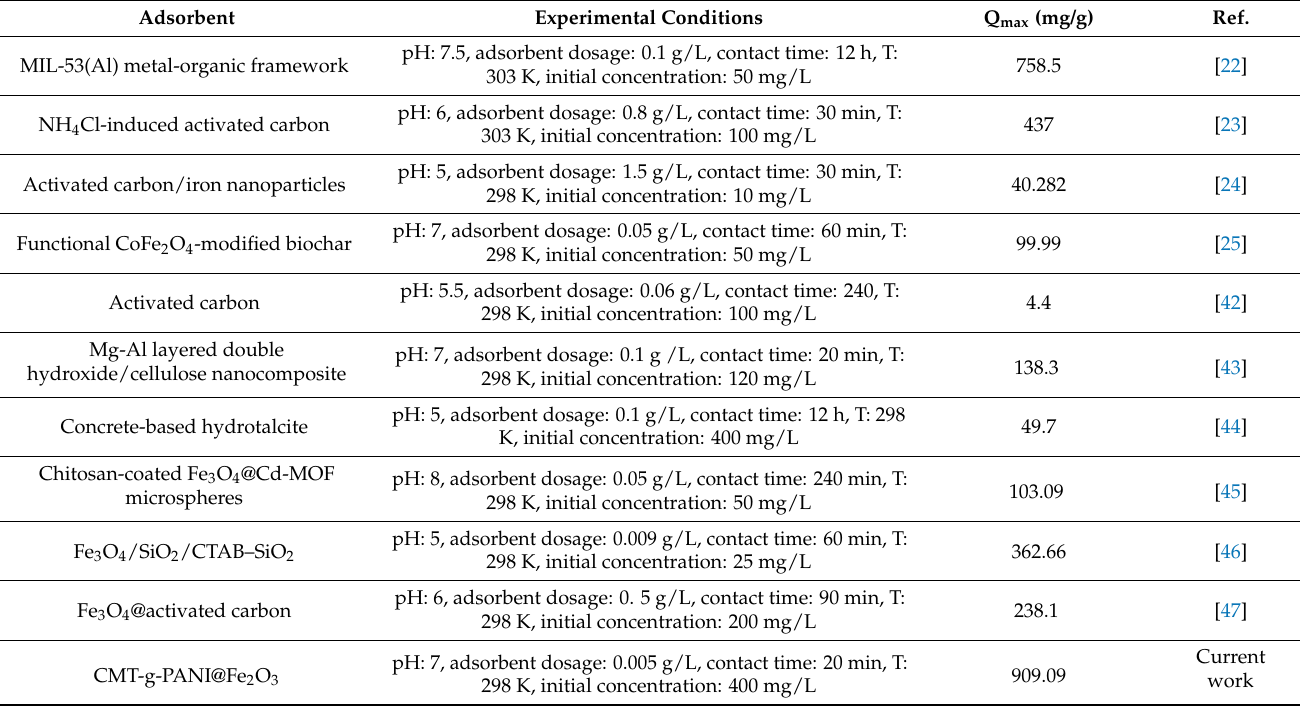
Table 3. Assessment of the maximum adsorption capacity of CMT-g-PANI@Fe 2 O 3 bionanocomposite with other reported studies.